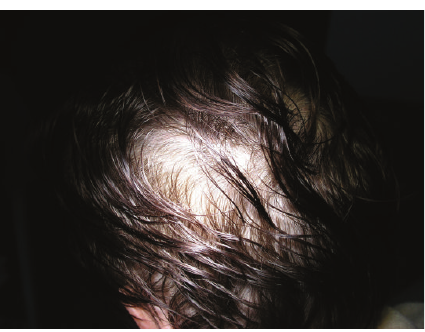
Figure 3: Diffuse